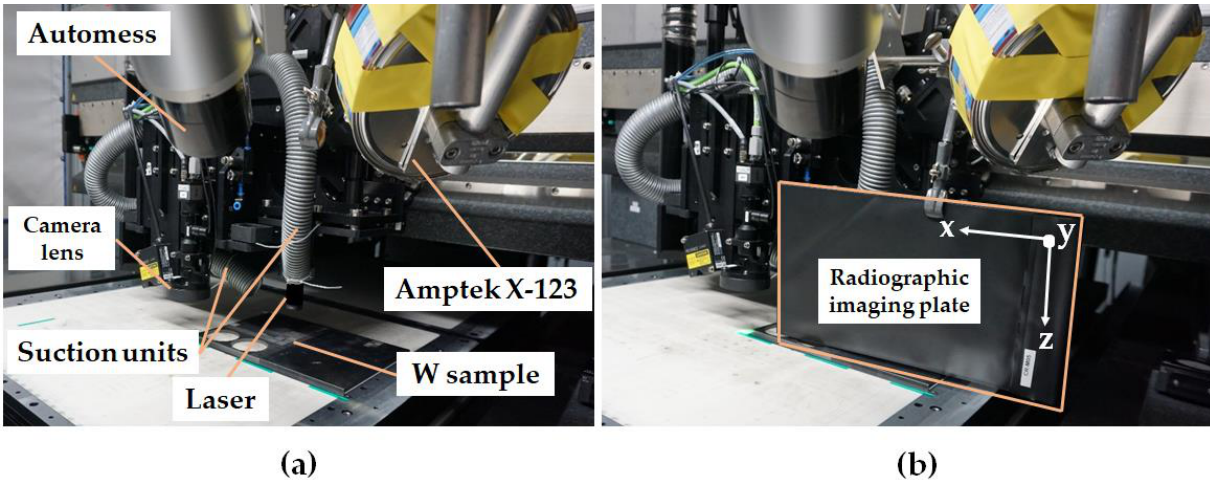
Figure 3. ( a ) Experimental setup and positioning of the measuring devices in the interior of the USP-laser machine. The Amptek X-123 spectrometer was placed in a tinplate box with an opening in front of the window and additionally covered with seven layers of 13 µm thick aluminum foil for shielding to prevent electromagnetic compatibility influences. ( b ) Placement of the radiographic imaging plate to detect the direction and homogeneity of the X-rays emission during USP-laser processing.